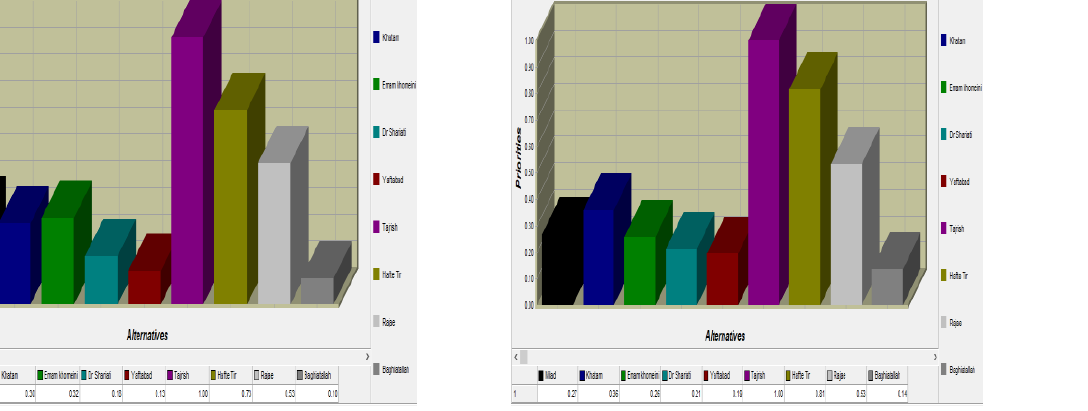
Figure 12. Ranking hospitals in terms of index I . Figure 13. Ranking hospitals in terms of index J.